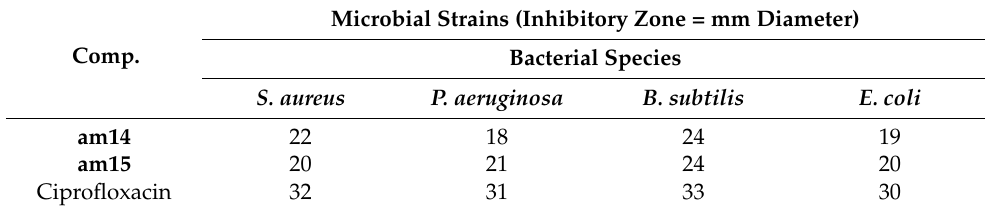
Table 8. Antimicrobial activity (Inhibitory Zone = mm diameter) of the compounds ( am14 – am15 ).